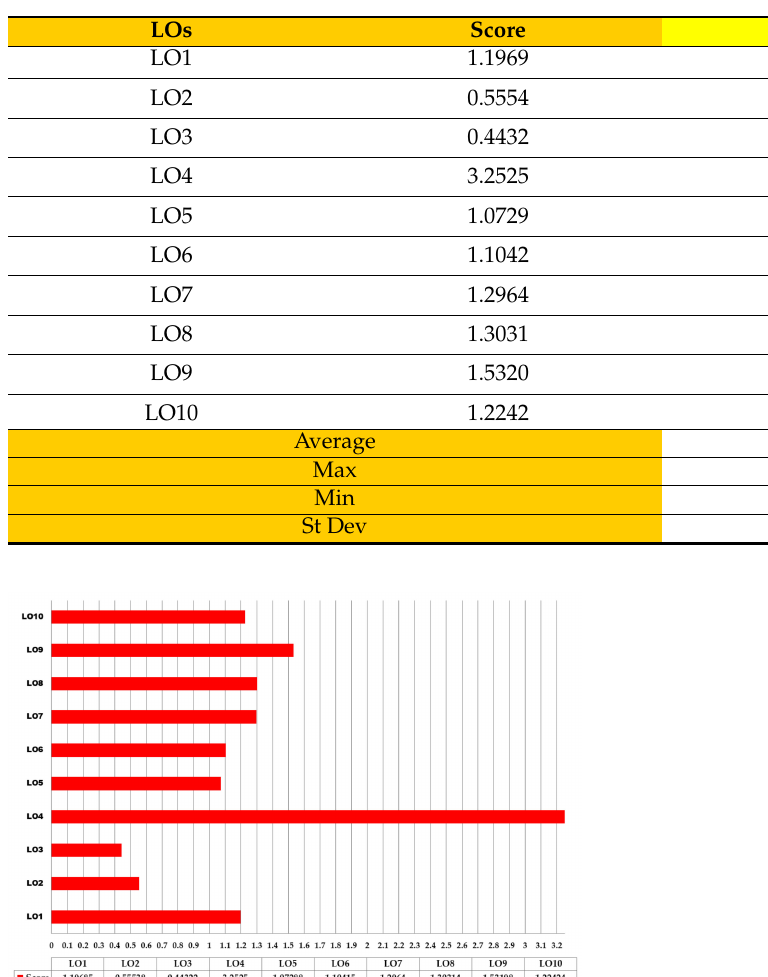
Table 8. Rank and score before alliances (calculated by researcher).